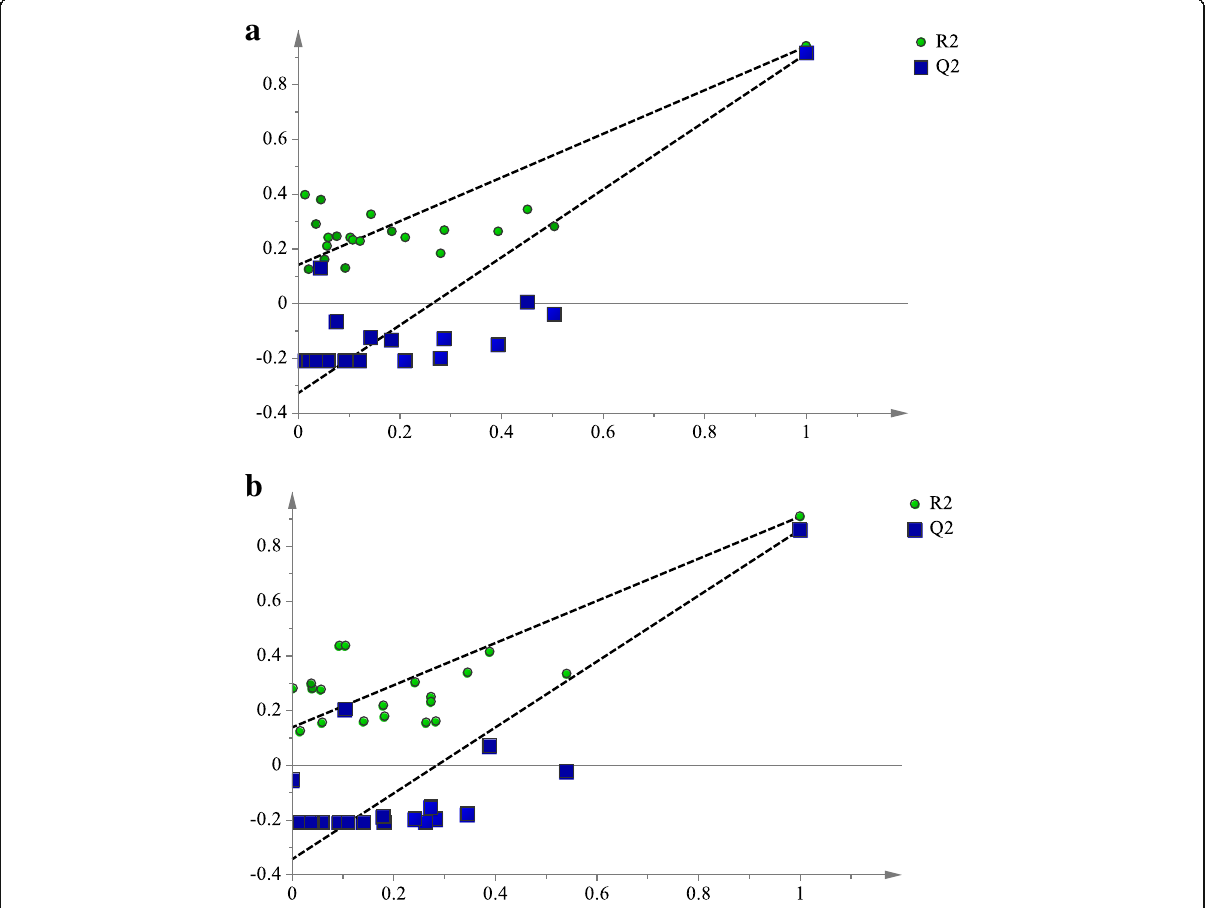
Fig. 4 Permutation plots of PLS model describing the R 2 and Q 2 Y-intercepts for DPPH free radical scavenging ( a ) and α -glucosidase inhibitory ( b ) activities of N. oleracea